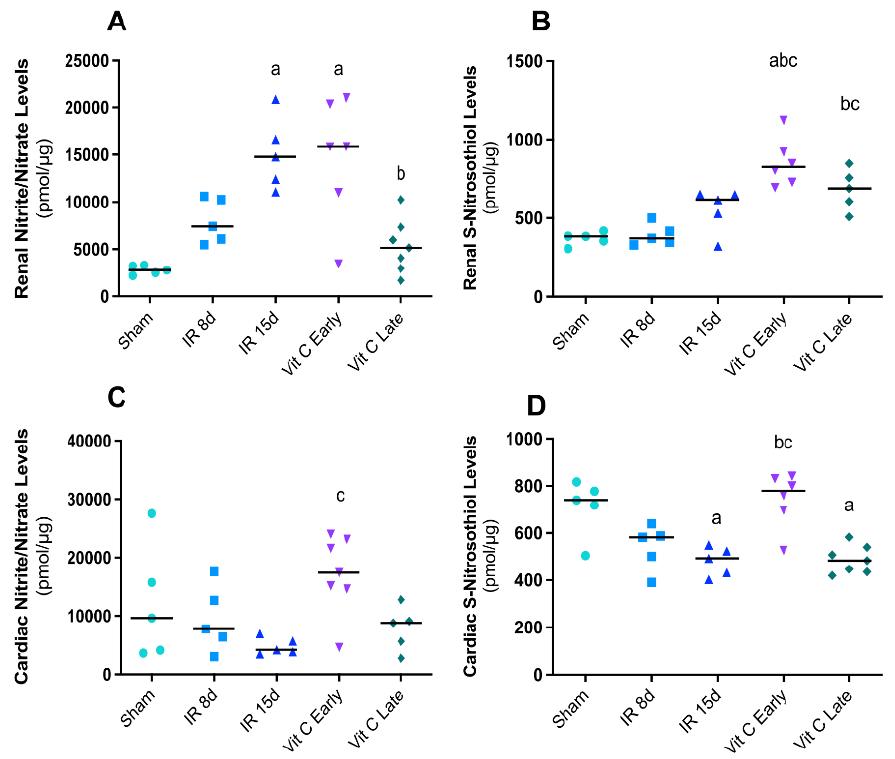
Figure 5. Impact of vitamin C on nitric oxide levels in CRS 3. Nitrite levels ( A ) and S-nitrosotiol levels ( B ) in the kidney. Nitrite levels ( C ) and S-nitrosotiol levels ( D ) in the heart. Data are expressed as the mean ± standard error of mean (SEM), and one-way ANOVA followed by the Tukey’s post hoc test were performed. a vs. sham, p < 0.05. b vs. IR8d, p < 0.05. c vs. IR15d, p < 0.05.